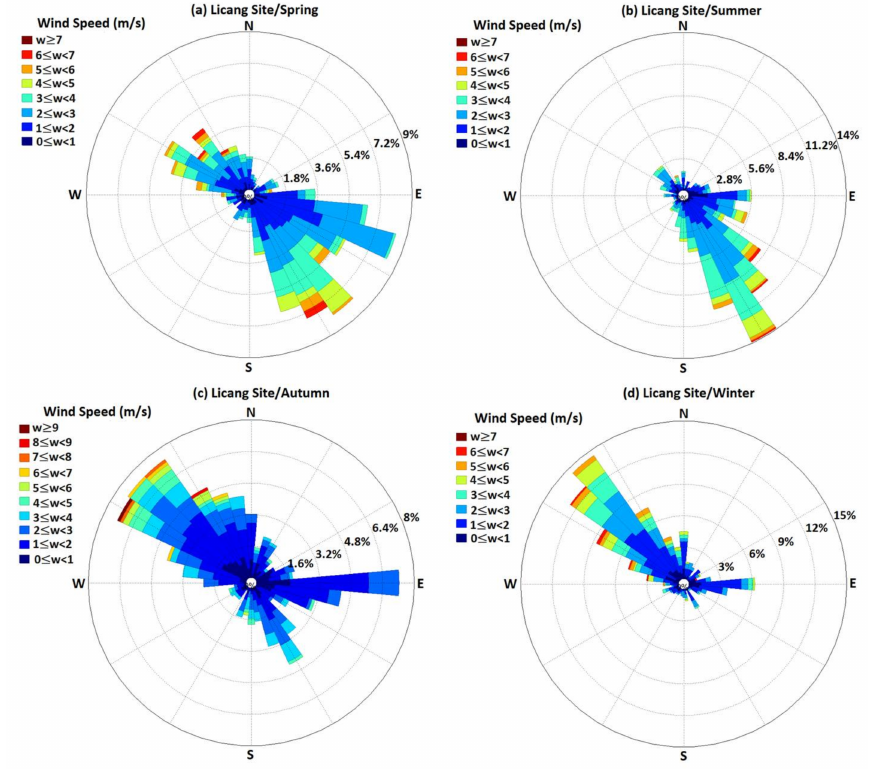
Figure 1. Wind speed and direction rose charts in winter at the Licang